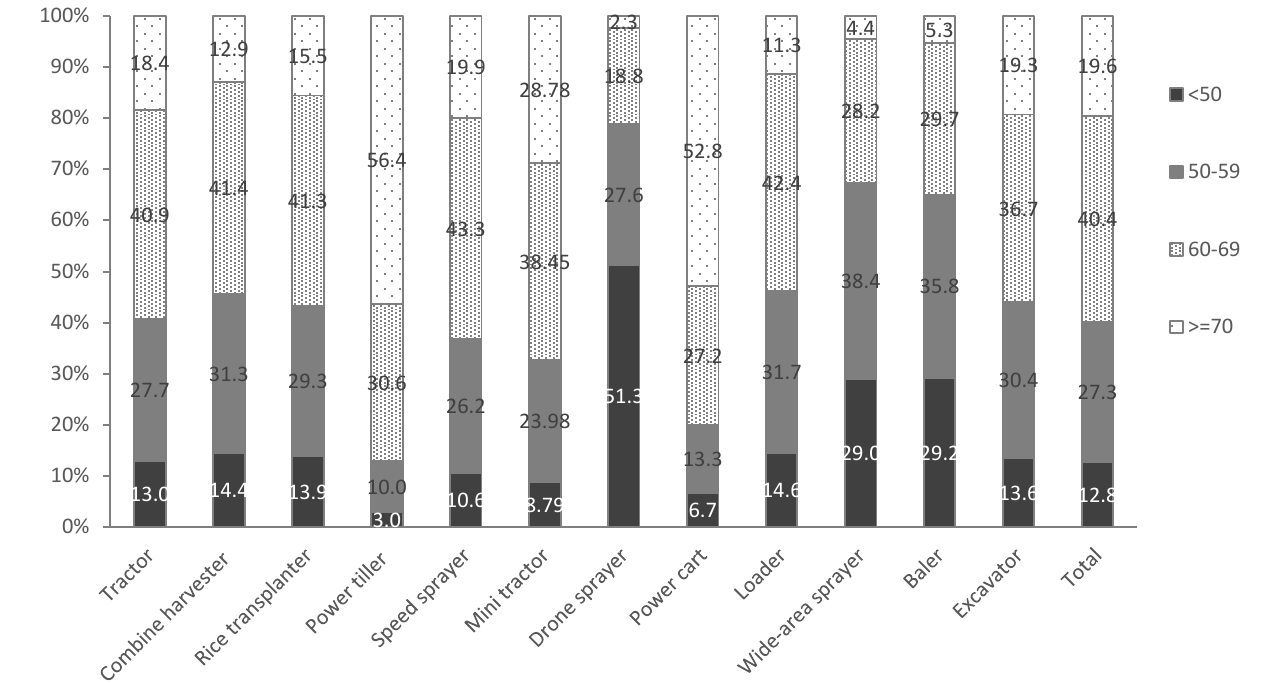
Figure 2. Ages of agricultural machine insurance contractors by agricultural machinery type. Table 1. Incidence rate of injuries related to agricultural machines among subscribers from 2014 to